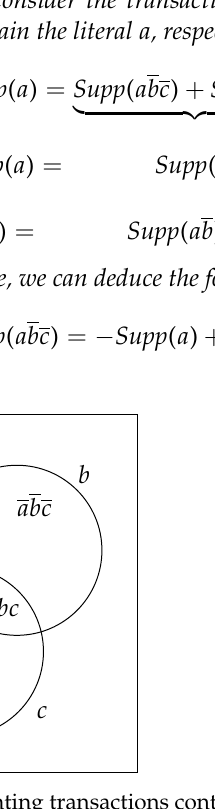
Figure 1. Sets representing transactions containing literals a , b , and c